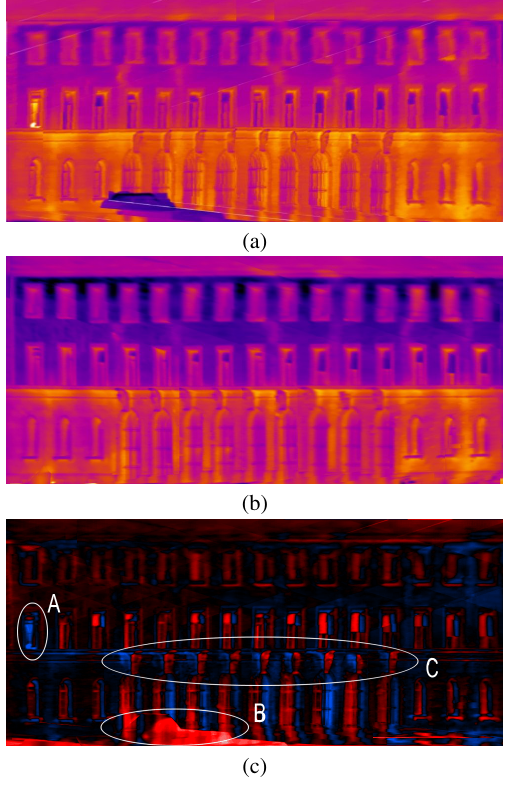
Figure 8. Combination of texture from forward and backward viewing images. a) texture from forward viewing images. b) texture from backward viewing images. c) Difference image after texture co-registration. Black: constant intensity in both images. Red: higher intensity in backward viewing texture. Blue: higher intensity in forward viewing texture. A) Windows that was close after the forward viewing image recording. B) Car in front